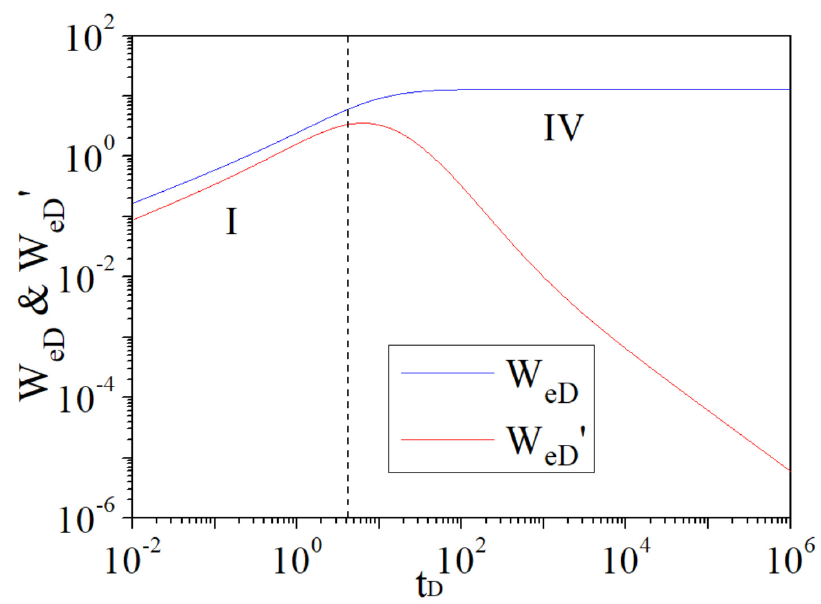
Figure 3. Dimensionless water influx characteristic curves of a homogeneous edge water reservoir.